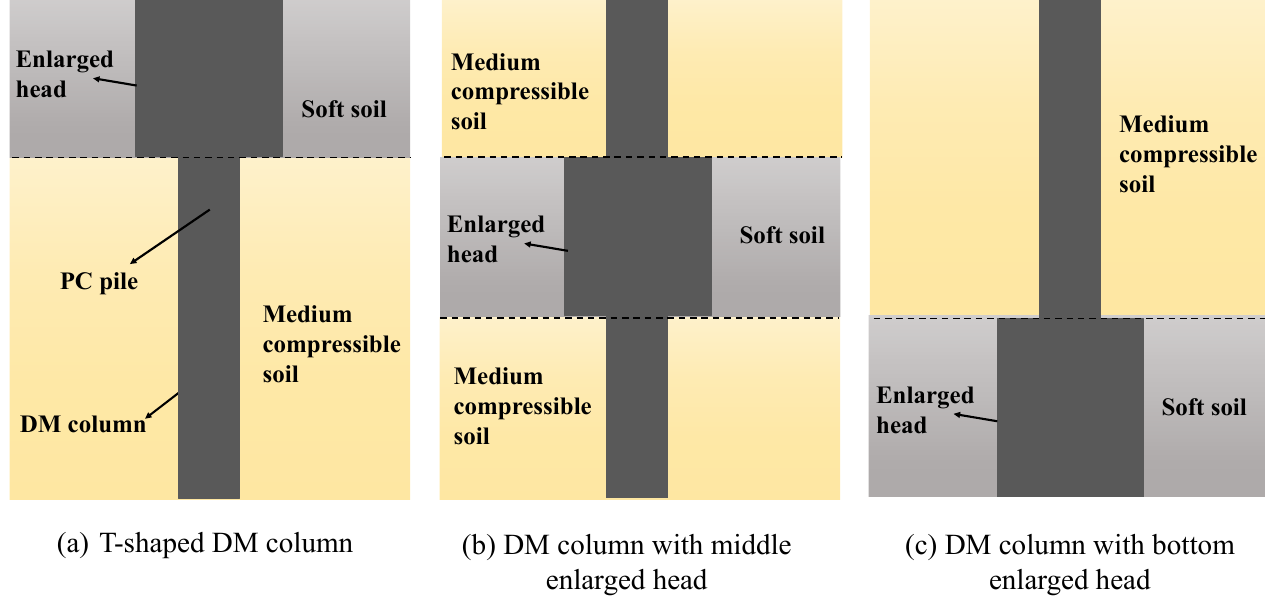
Figure 7. Schematic diagram of VDM columns reinforcing layer-forming soft ground.